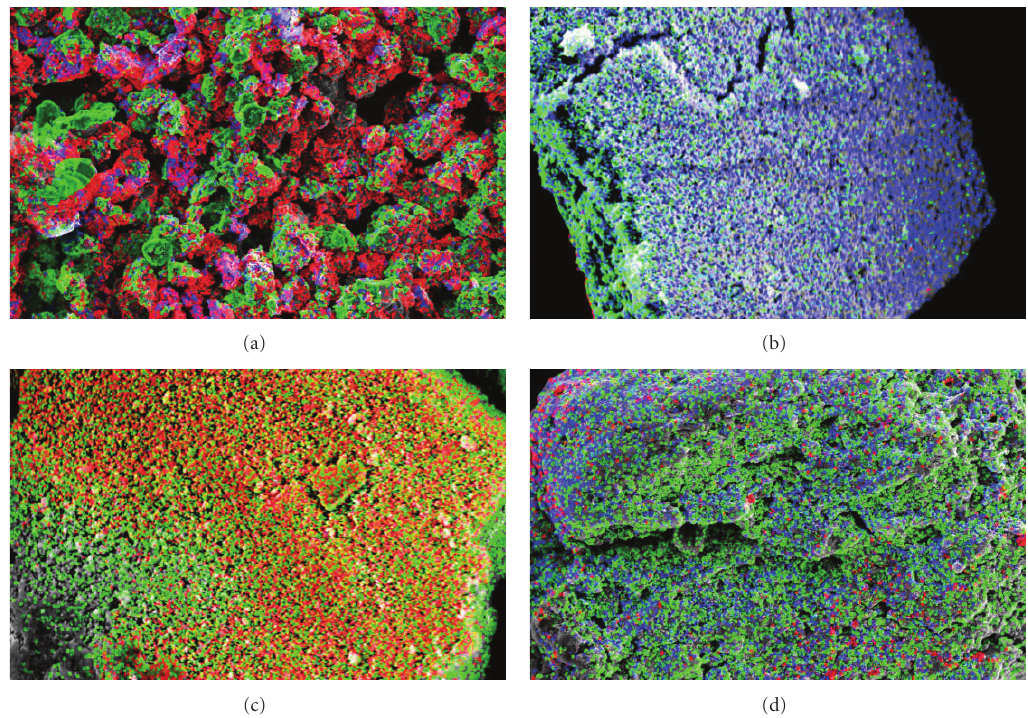
Figure 1: X-ray mapping images of (a) MN-1 (red-Fe, green-C, and blue-O), (b) MN-2 (blue-Fe, green-O, and red-C), (c) MN-3 (green-Fe, red-O, and blue-C), and (d) MN-4 (red-Silica, green-Fe, and blue-O).